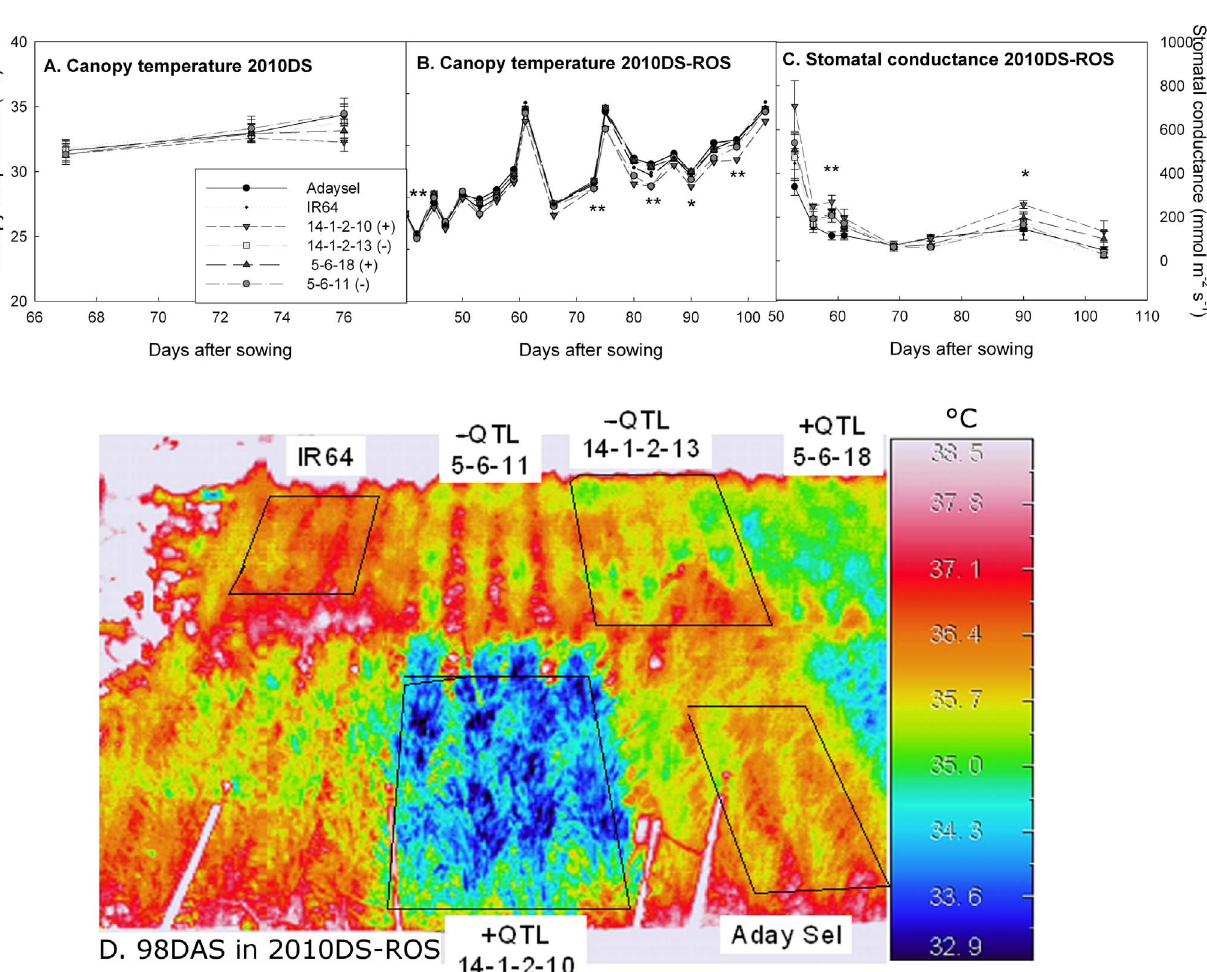
The allelic source for all QTL was Aday Sel. LOD, Logarithm of odds ratios; R 2 , Phenotypic variance; Additive effect, grain yield (kg ha 2 1 ) additive effect over the population mean presented in Table S1.